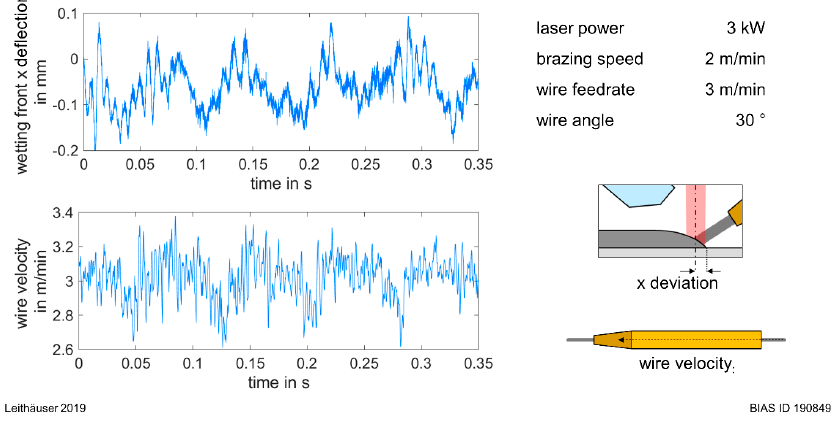
Figure 4. Section of the wetting front and the wire feed rate of a representative sample.